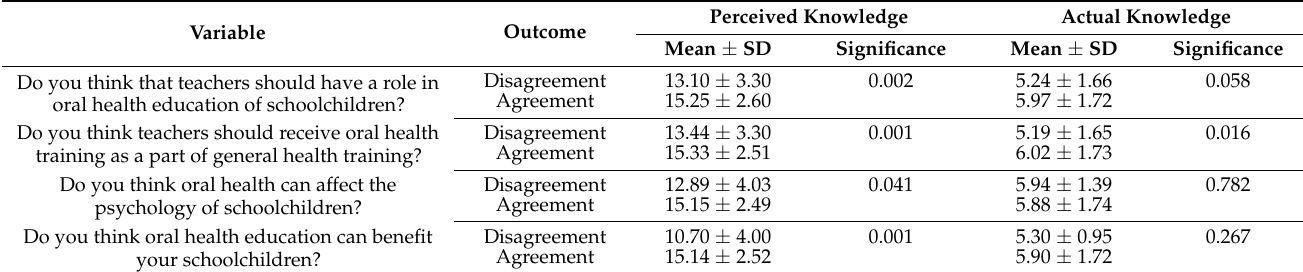
Table 9. Impact of elementary schoolteachers’ oral health knowledge on their attitudes.